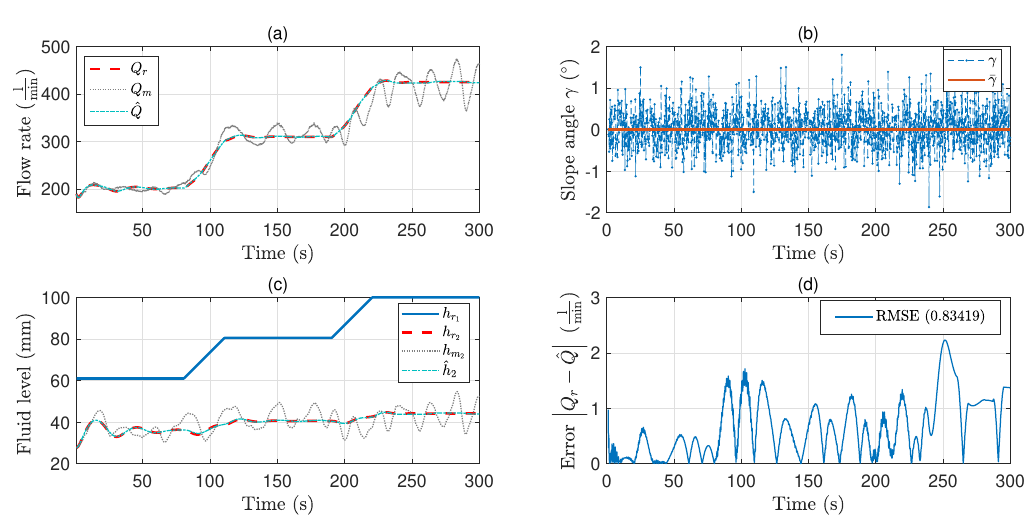
Figure 9: (a) The reference Q r with the horizontal channel and estimated fluid flow rate ˆ Q are shown together with the model flow rate Q m due to the changed slope. (b) The actual varying channel bed angle γ is used for the model and the mean angle ¯ γ is used in the estimator. (The bottom slope S b = sin( γ ) in radian. ). (c) The different fluid levels when the bottom slope is changed. h r reference fluid levels with the horizontal bottom slope. ˆ h 2 is the estimated fluid level from the MHE and h m is the changed measurement due to the slope change. (d) The absolute error between the 2 actual Q r and estimated ˆ Q flow rates.